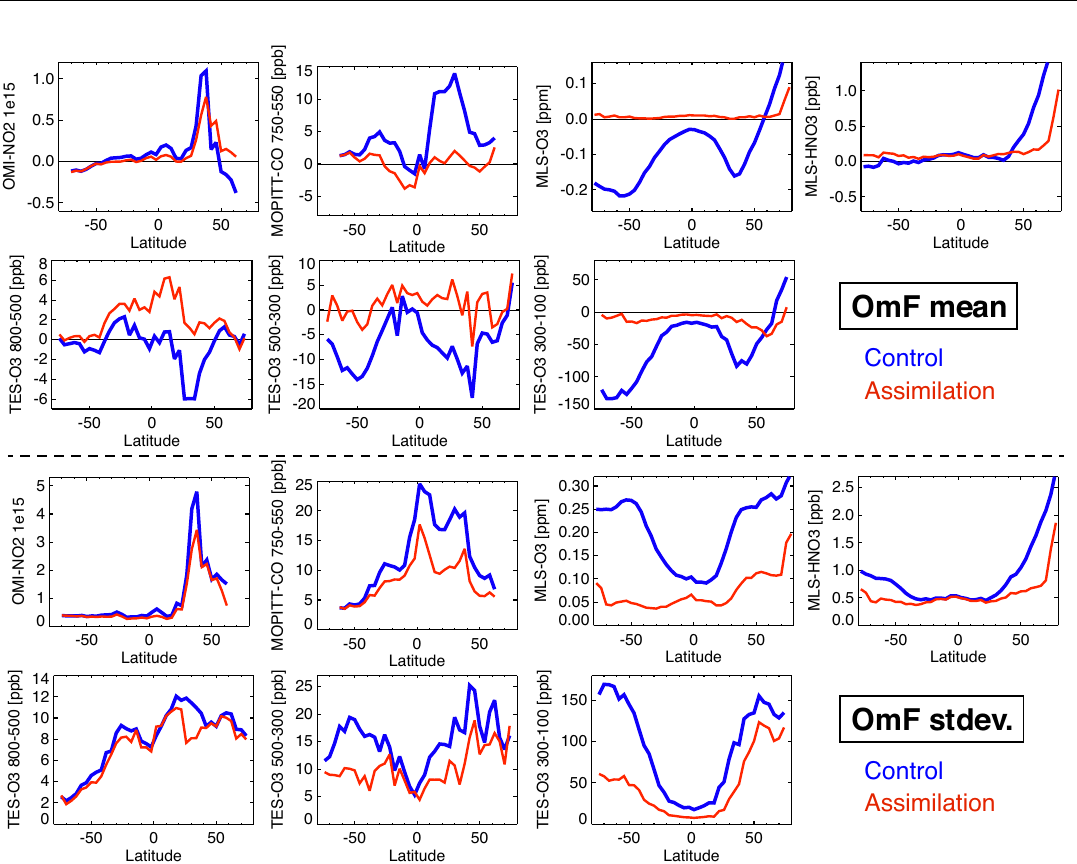
Fig. 7. Latitudinal distributions of the mean OmF (upper panels) and its standard deviation around the mean (lower panels) estimated in the observation space for each assimilated data set, averaged over the period 16–30 January 2007. The results are shown for the data assimilation run (red) and the control run